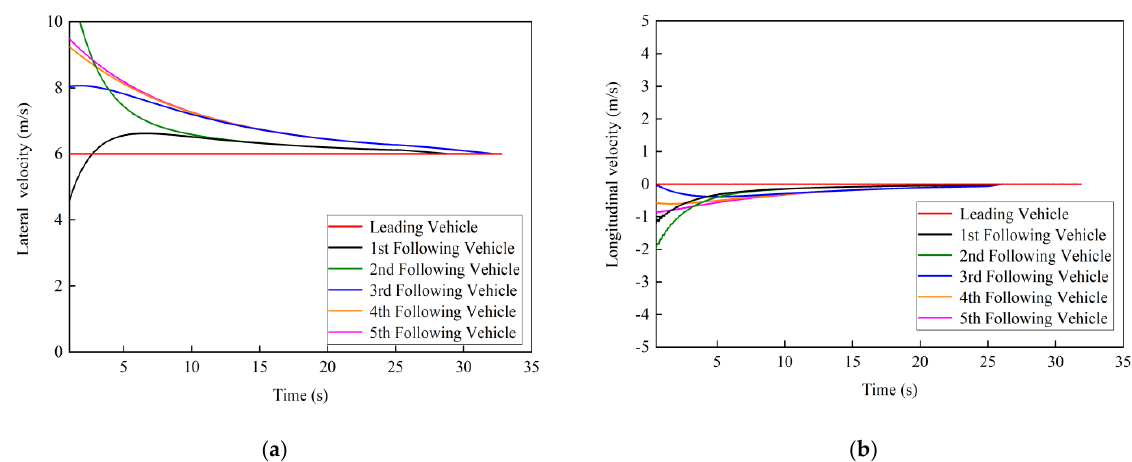
Figure 6. The velocities of the CAVs during the platoon formation process: ( a ) lateral velocity; ( b ) longitudinal velocity (scenario I